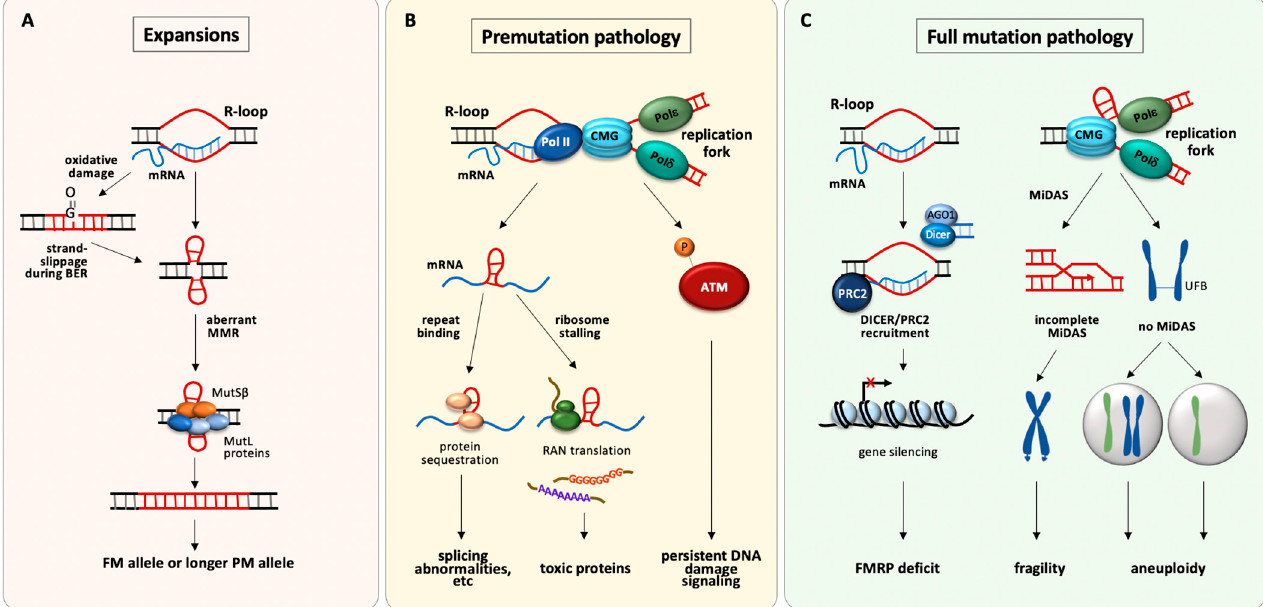
Figure 2. Models for the roles of non-canonical DNA and RNA structures in the etiology of the repeat expansion mutation and the resultant pathology seen in individuals with PM and FM alleles. ( A ) R-loops formed during transcription contain a region of single-stranded DNA that would be prone to oxidative damage. Base excision repair of such damage could generate loop-outs by strand-slippage or strand-displacement during repair synthesis [71,77,78]. R-loops may also facilitate the direct formation of loop-outs, first by the unpaired non-template strand when the template strand is involved in the RNA:DNA hybrid, and subsequently by the template strand after the R-loop is resolved. The loop-outs are bound by mismatch repair factors like MutS β and MutL γ [79–82] and are processed via a DSB [83] to generate expansions. ( B ) CGG-hairpins in the FMR1 transcript can bind and sequester proteins [84,85] or trigger RAN translation of toxic proteins [86,87]. Persistent R-loops, perhaps exacerbated by replication-transcription collisions may result in DSBs that cause persistent DNA damage signaling [49]. ( C ) R-loop formation allows the recruitment of PRC2 to the FMR1 gene [88]. DICER complexes associated with dsRNA produced from the FMR1 locus [36] may also contribute to silencing by facilitating recruitment of SUV39H [89]. Secondary structures may cause stalling of the replication fork that triggers MiDAS [90]. Failure to complete MiDAS results in chromosome fragility, while failure to initiate MiDAS results in the formation of UFBs and ultimately the gain or loss of the affected X chromosome [90] .